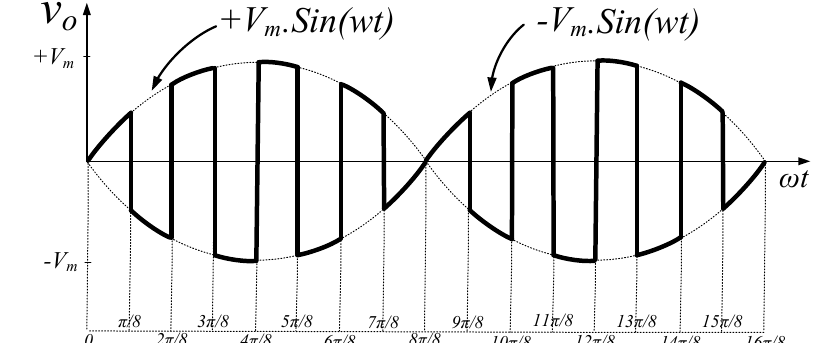
Figure 4. Voltage waveform for 400 Hz output frequency.